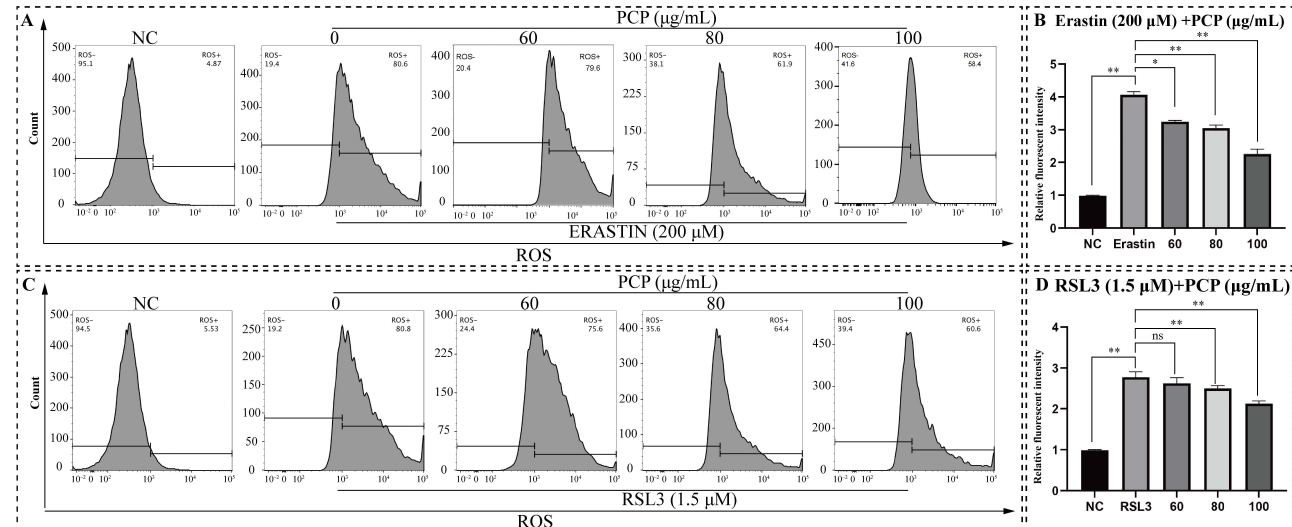
Figure 9. PCP scavenged ERASTIN/RSL3-induced intracellular ROS in the microglia. The cells were treated with ERASTIN (200 µ mol) or RSL3 (1.5 µ mol) and PCP at different concentrations (0, 60, 80, and 100 µ g/mL) for 24 h. We set the NC group treated with DMEM as the control. Then, we stained the cells using a DCFH-DA probe, detected them with a flow cytometer, and established the fluorescence intensity with FlowJo. The ROS level in microglia ( A , C ). The relative fluorescence intensity of ROS inside microglia ( B , D ). ( ns p > 0.05, * p < 0.05 and ** p <